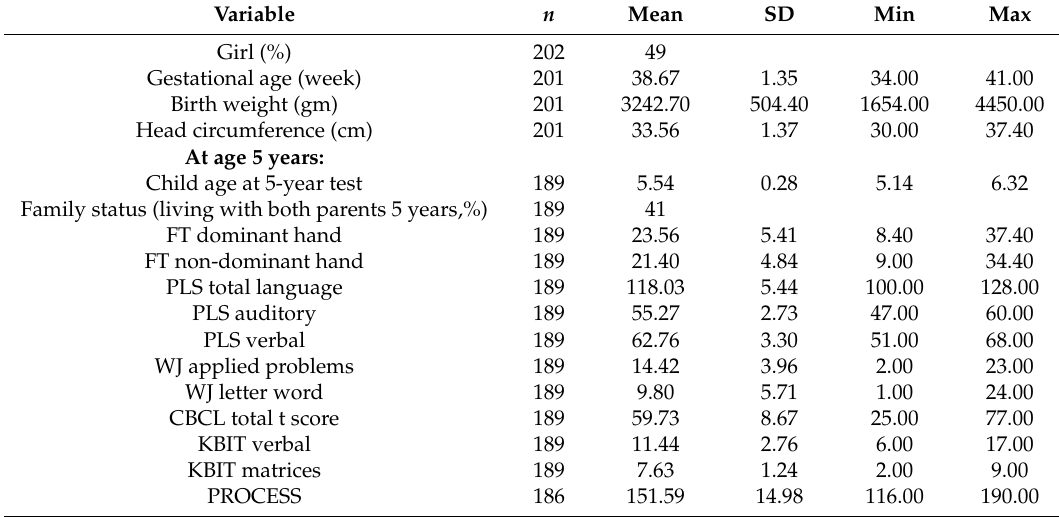
Table 2. Child mean, SD, and range for demographic, birth outcome and neurocognitive